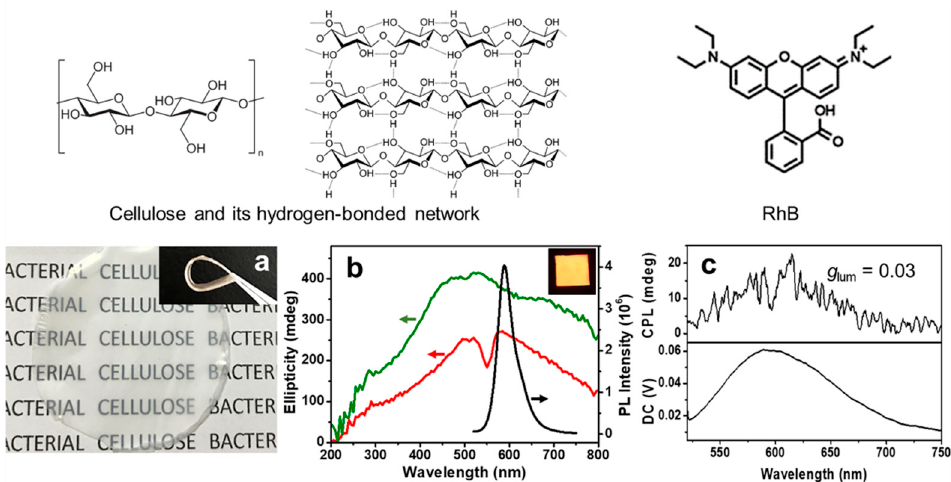
Figure 1. ( a ) Photograph of BC-RhB (rhodamine B) paper showing its good transparency and flexibility (inset). ( b ) Circular dichroism (CD) spectra of BC-RhB (red line) and pristine BC-paper (green line) (left vertical axis) and photoemission spectrum of BC-RhB (right vertical axis).